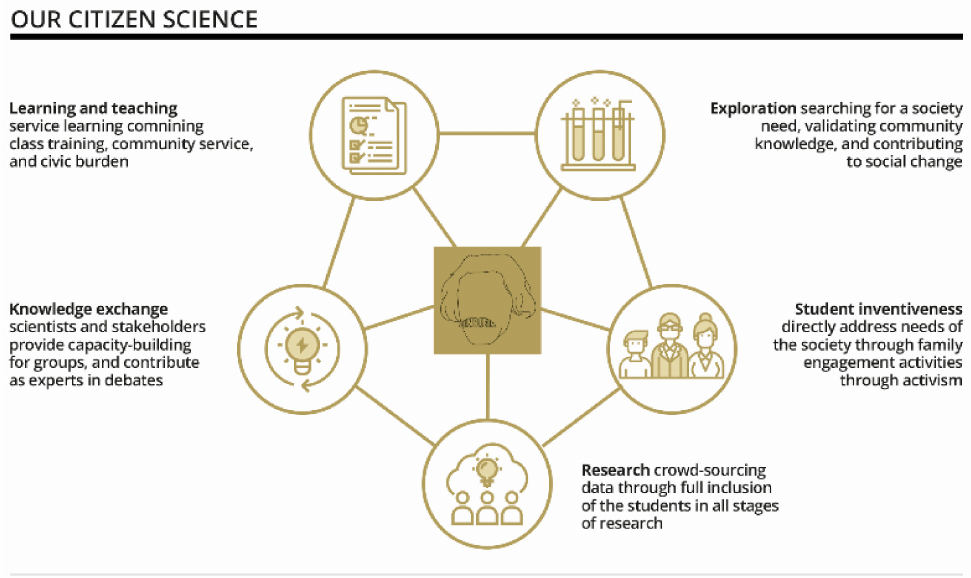
Figure 7. Engaging in the strategic activities of science is more than simply going through the motions. Engaging in the research provided a chance for students to graft within the explanation framework of statements and think through that practice, in particular when they discussed their labor to an audience. The great merit of those enthusiasts adolescents was the seminal one, a sowing that produced fruits years later. (In the center, the original logo of the Einstein Committee designed by the graphic designer Armando